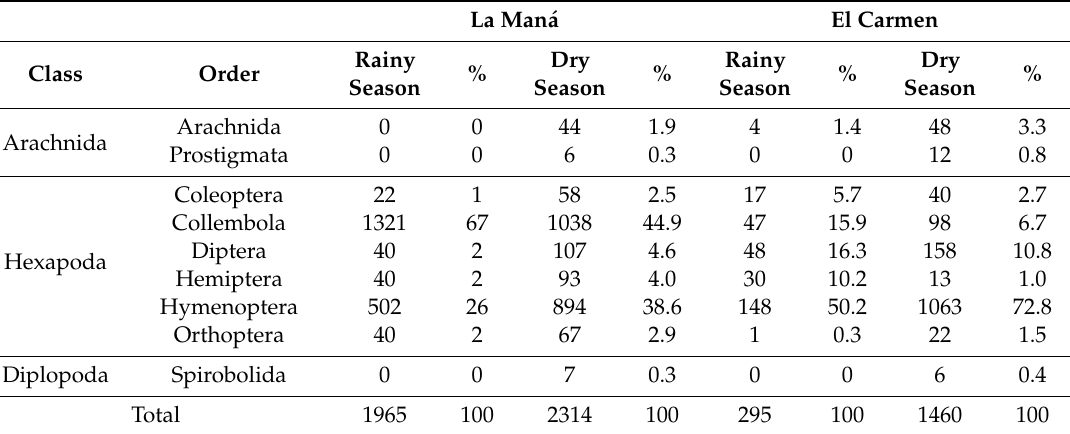
Table 4. Arthropod abundance distributed by taxonomic groups during the rainy and dry seasons in two ecological sites (El Carmen and La Man á ) in 2014. Class Order